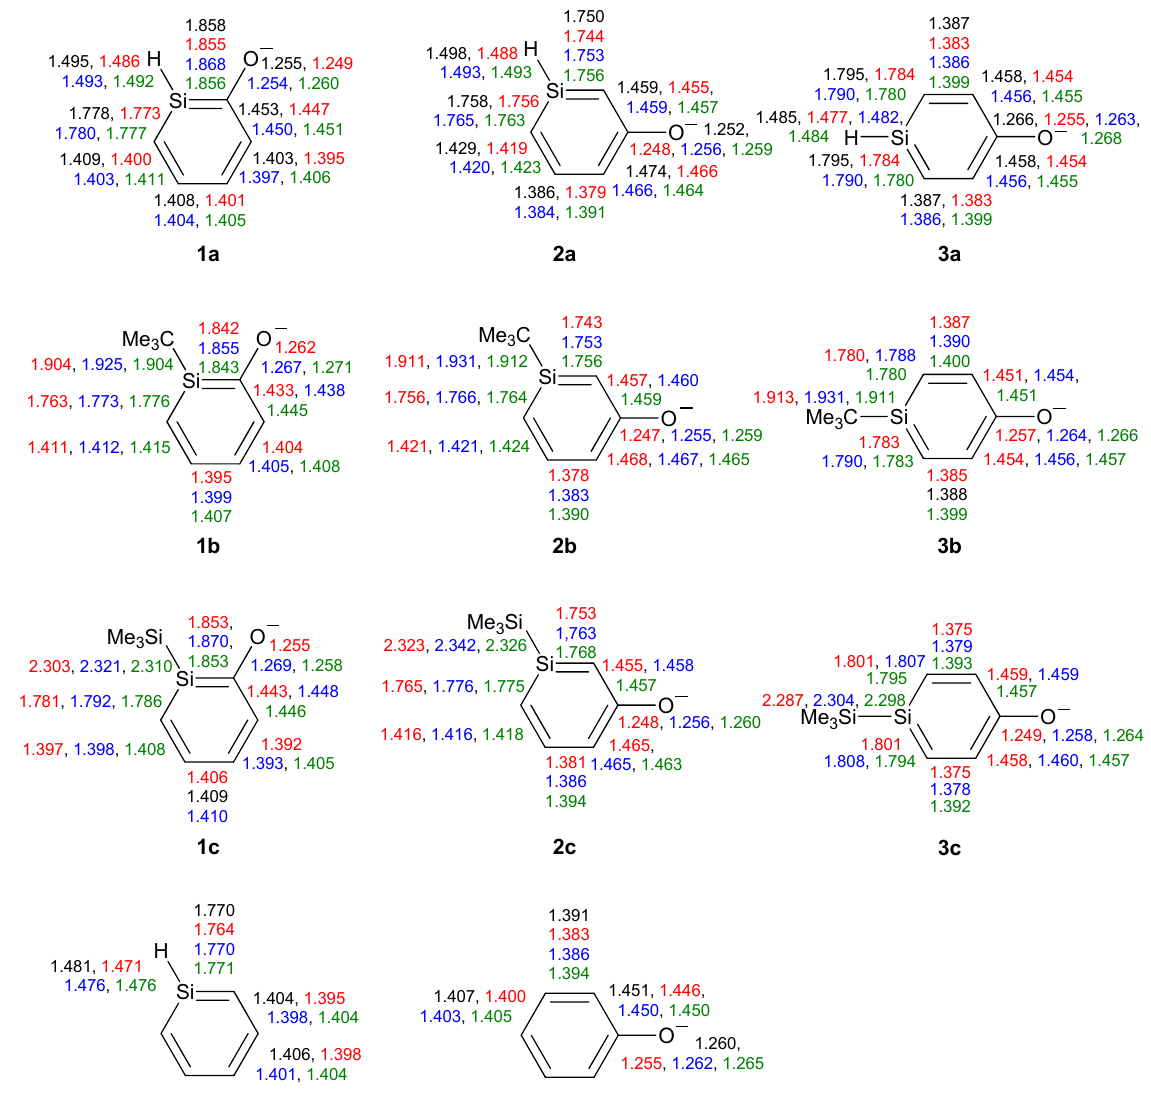
Figure 1. Bond lengths (Å) of silaphenolates 1a – 3c , silabenzene SiC phenolate C H O − calculated at the CCSD/6-311G(d) (black), M062X/6-311G(d) (red), 6 5 B3LYP/6-311G(d) (blue), and MP2/6-311G(d) (green) levels. All sums of valence angles at Si ( Σα (Si)) equal